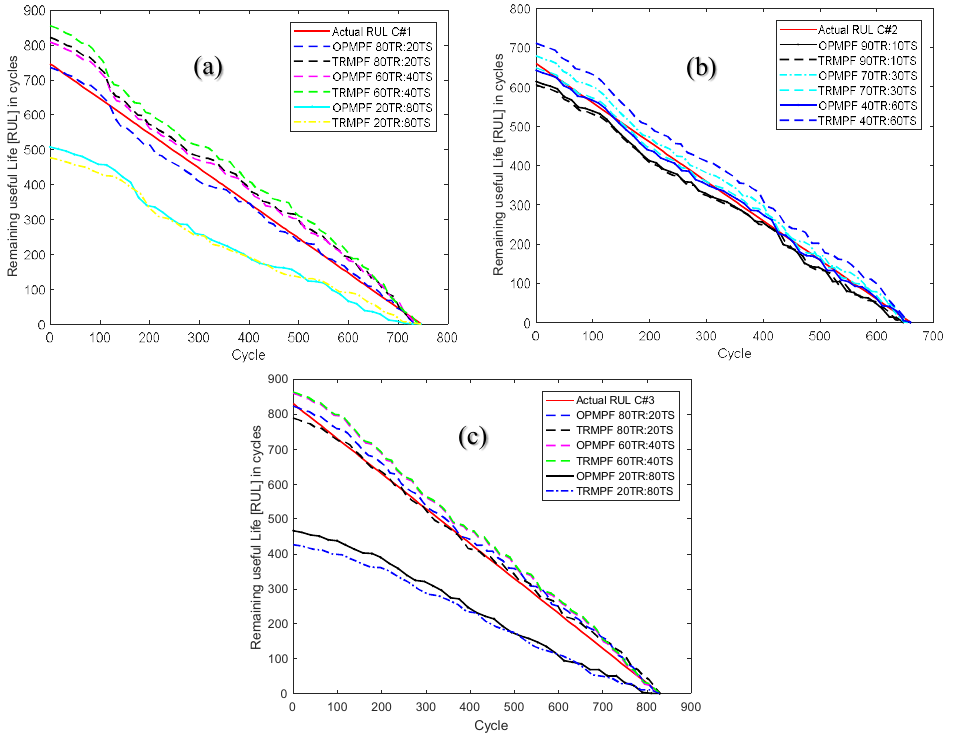
Figure 8. Alpha–Lambda accuracy plot of the RUL of the Li + batteries using a combination of some of the TTDP, ( a ) battery C#1, ( b ) battery C#2, ( c ) battery C#3.